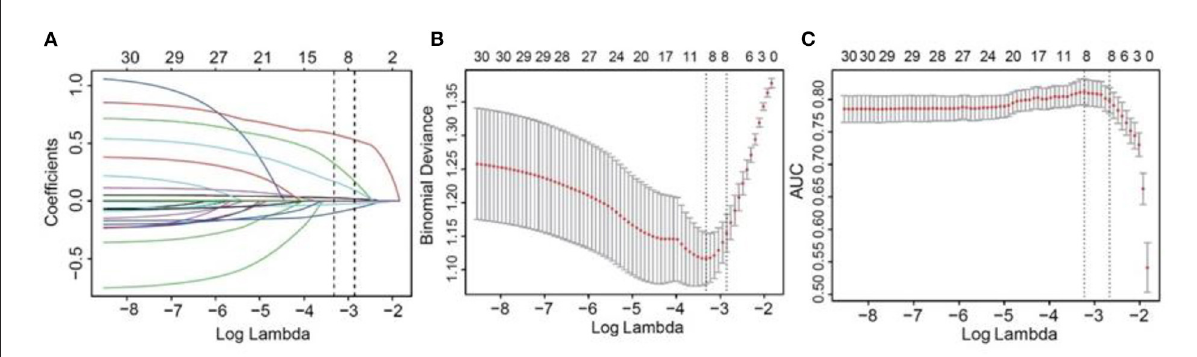
FIGURE2 Selection of risk factors of infectious diseases using LASSO regression algorithm. A vertical line was plotted at the given lambda, selected by 10-fold cross-validation with minimum classification error and minimum classification error plus one standard error. For the optimal lambda that gives minimum classification error, 8 features with a non-0 coefficient were selected. (A) LASSO coefficient profiles of the candidate variables. (B) The binomial deviance with 95% CI (y-axis) was plotted against log (lambda) (bottom x-axis), when the number of included variables were changed (upper x-axis). (C) The AUCs with 95% CI (y-axis) were plotted against log (lambda) (bottom x-axis), when the number of included variables were changed (upper x-axis). LASSO, the Least Absolute Shrinkage and Selection Operator; CI, confidence interval; AUC, areas under the curve.